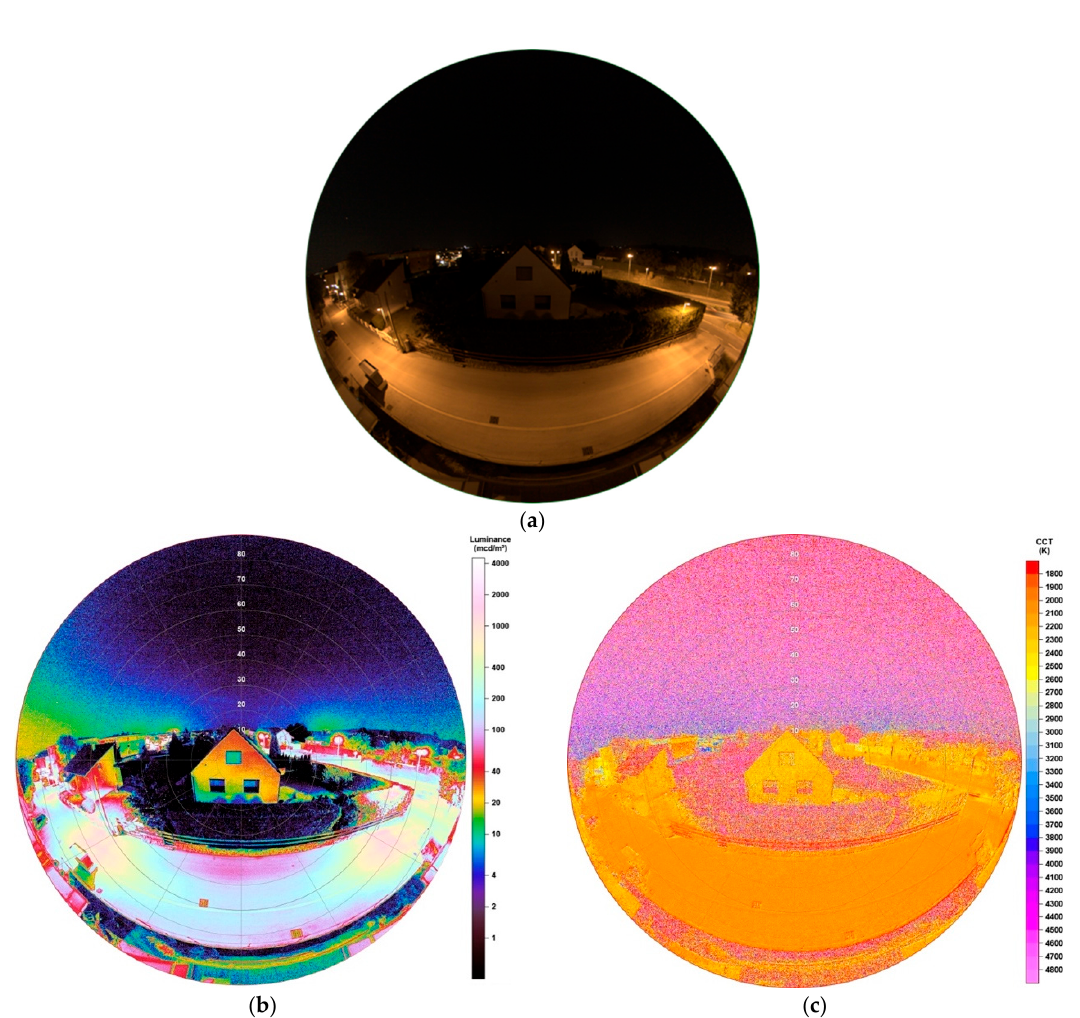
Figure 17. ( a ) Image of illuminated street and building during night-time before conversion to full cut-off-LEDs, taken with fisheye lens for detailed analysis (date: 30.07.2018, 23:22 h; exposure time: 0.5 s); ( b ) Luminance matrix as displayed by SQC; ( c ) CCT matrix as displayed by SQC.